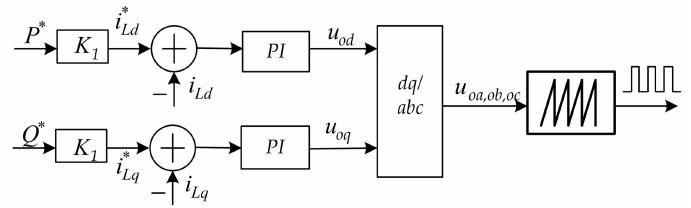
Figure 4. Power control block of the